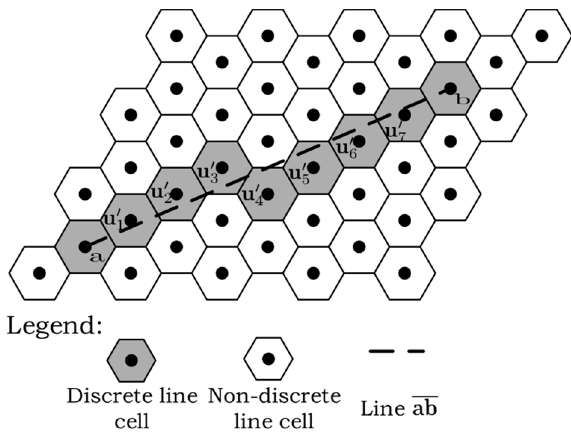
Figure 4. Discrete line in a hexagonal grid.